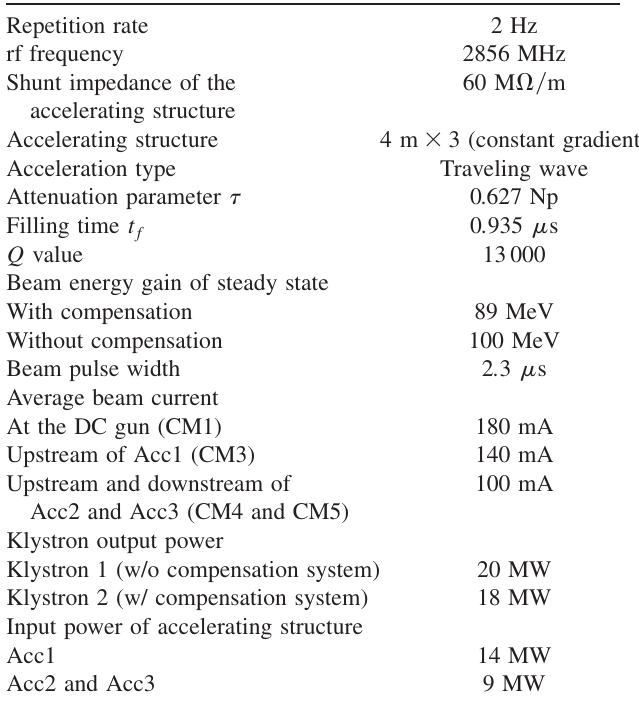
TABLE I. Main parameters of beam test.